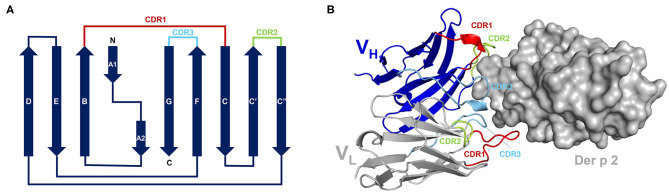
(A) A topological diagram of IgG VH. β-strands are shown as arrows that indicate direction of the peptide. N- and C-termini, as well as individual β-strands are labeled. Loops corresponding to three CDRs are highlighted using different colors. The figure was prepared based on a diagram presented by Bodelón et al. (65). (B) Complex between 7A1 and Der p 2.0103. Only variable domains of the 7A1 antibody are shown. CDRs are marked using the same colors as used for the topological diagram. Der p 2.0103 is shown in surface representation.